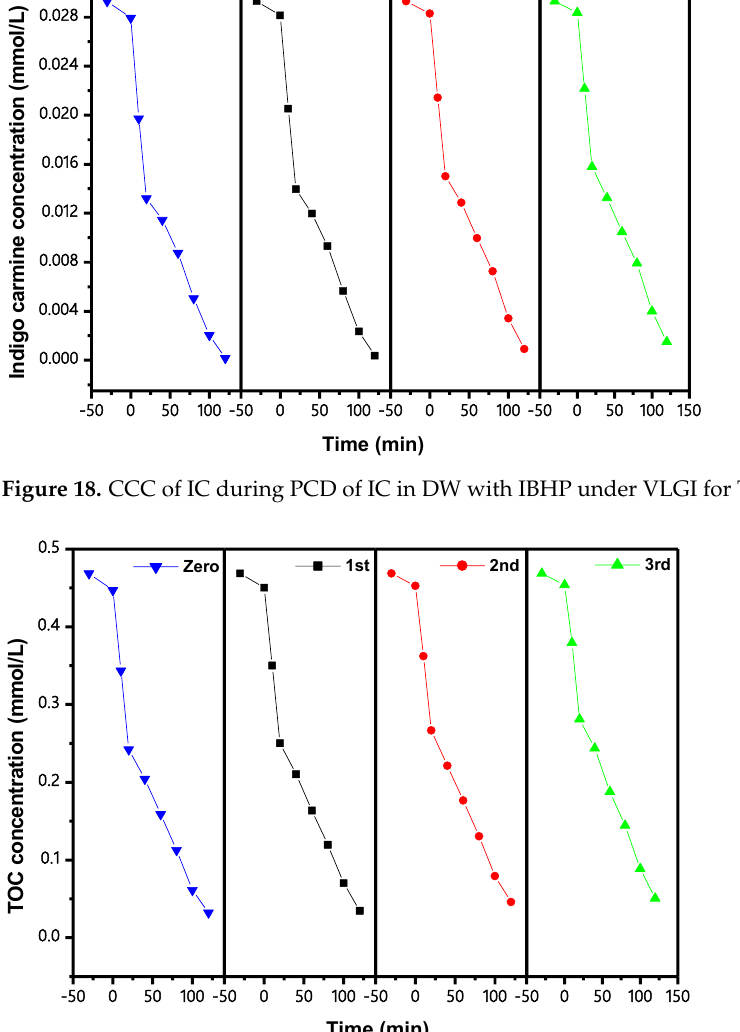
Figure 19. CCC of TOC during PCD of IC in DW with IBHP under VLGI for TCDT. k (KCK), which was from the DCT IC concentration and VLGI time, with IBH, In 2 YSbO 7 , BiSnSbO 6 or N-TiO 2 as the catalyst, reached 0.0295 min − 1 , 0.01603 min − 1 , 0.01181 min − 1 and 0.00337 min − 1 , respectively. The KCK which came from the DCT TOC concentration and VLGI time reached 0.0178 min − 1 , 0.0136 min − 1 , 0.0103 min − 1 and 0.0026 min − 1 with IBH, In 2 YSbO 7 , BiSnSbO 6 or N-TiO 2 as the catalyst. The K TOC value obtained during IC degradation was lower than the K C value obtained when the same catalyst was